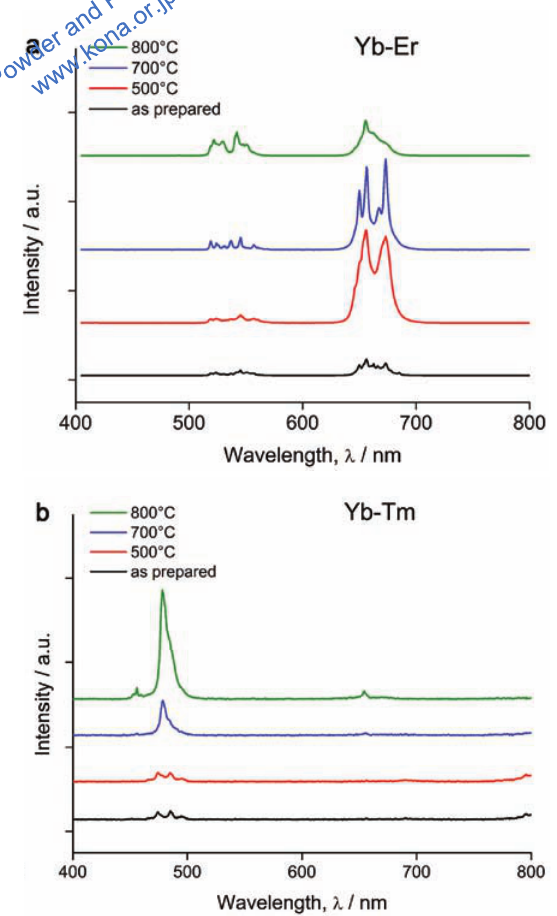
Fig. 5 Upconversion luminescence emission of NaYF with Yb-Er (a) and Yb-Tm (b) rare earth dopant couples. The relative peak intensities increase after sintering from 500 ℃ to 800 ℃